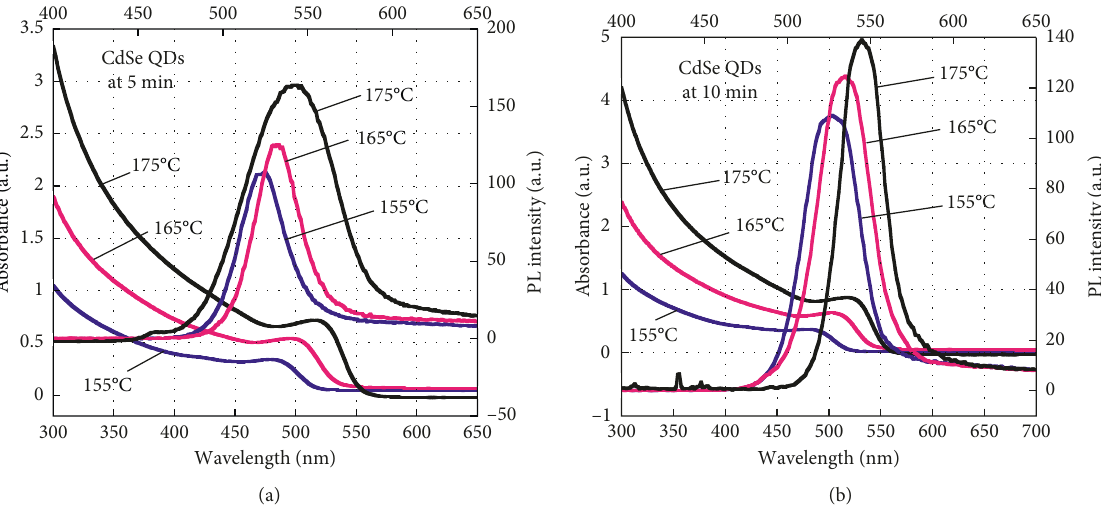
Figure 4: Absorbance and emission spectra of bare CdSe core QDs synthesized at 155 ° C, 165 ° C, and 175 ° C for 5min (a) and 10min (b), plotted as a function of photon wavelength.